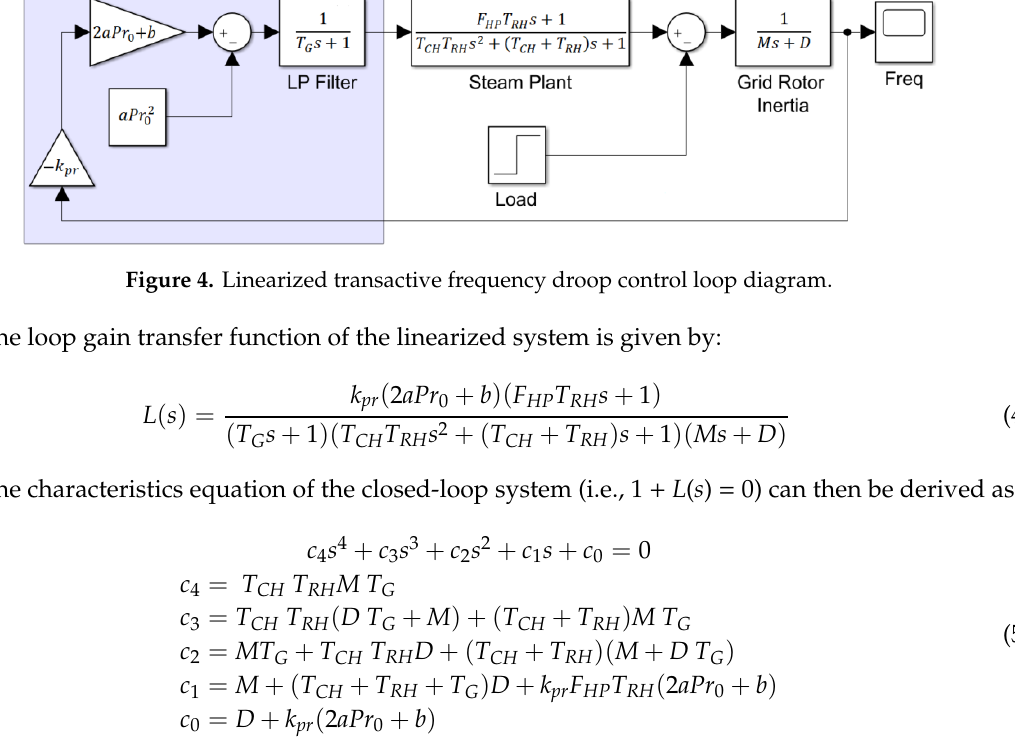
Table 1. System parameters mainly adopted from Reference [7].